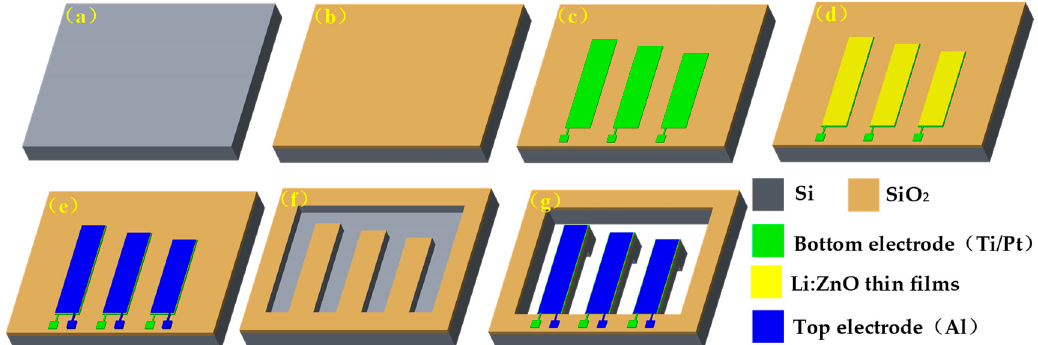
Figure 3. The main fabrication technology process of energy harvester: ( a ) cleaning silicon wafer; ( b ) growing SiO 2 layer; ( c ) sputtering Pt/Ti bottom electrode layer; ( d ) preparing LZO thin films; ( e ) depositing Al top electrode layer; ( f ) etching chip front side; ( g ) releasing cantilever beam.